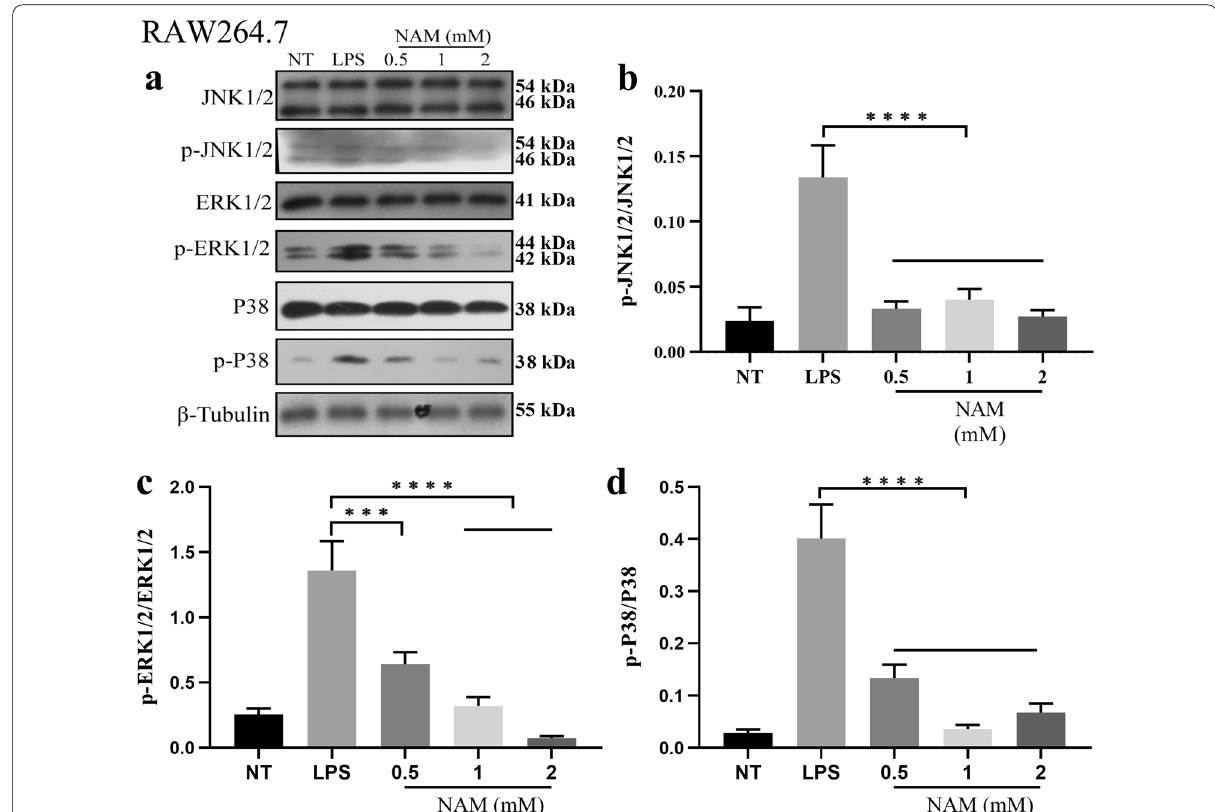
Fig. 6 Effect of NAM on MAPK signaling pathway in RAW264.7. The experiment was divided into 5 groups: NT, LPS, LPS and LPS 2 mM. a – d NAM was added 1 h before LPS was added, and the total protein of the cells was collected after LPS treatment for 3 h. The + phosphorylation of ERK, JNK and P38 were detected by western blot. The values are presented as the mean and **** p <